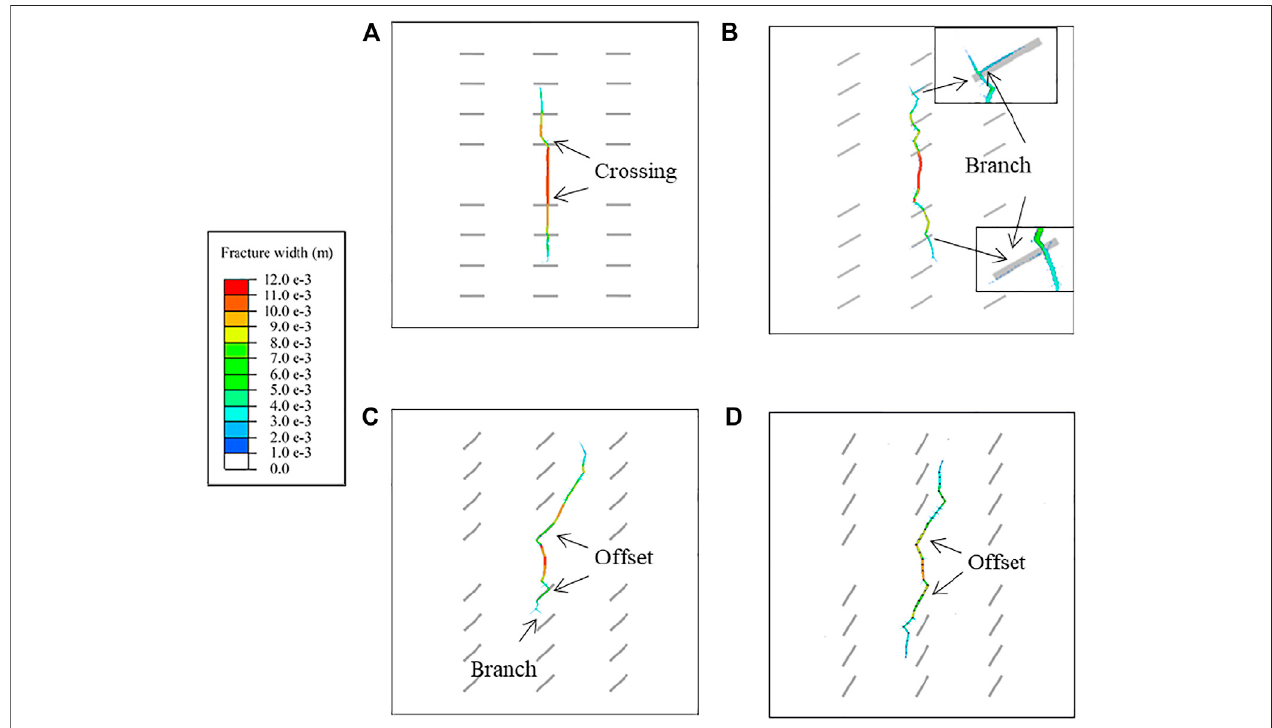
FIGURE 7 | Morphology of hydraulic fracture network under different approach angles: (A) 90 + in case 1; (B) 60 + in case 2; (C) 45 + in case 3; (D) 30 + in case 4.